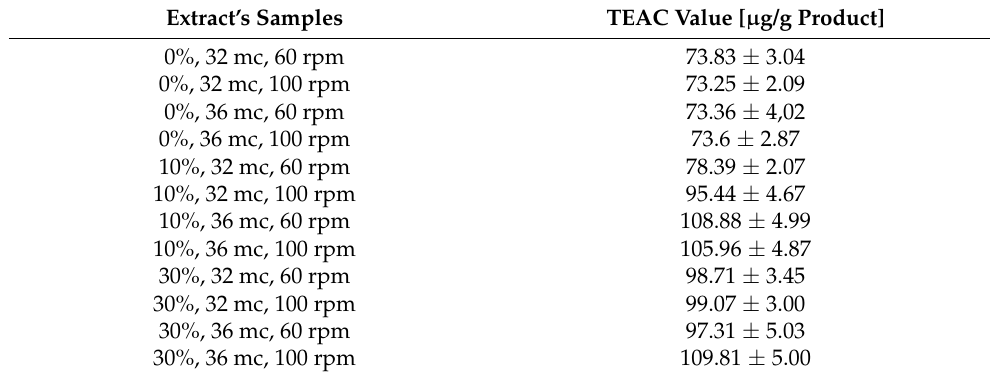
Table 1. TEAC value ( µ g/g product) calculated for all analyzed extract samples at 10 min from the DPPH reaction